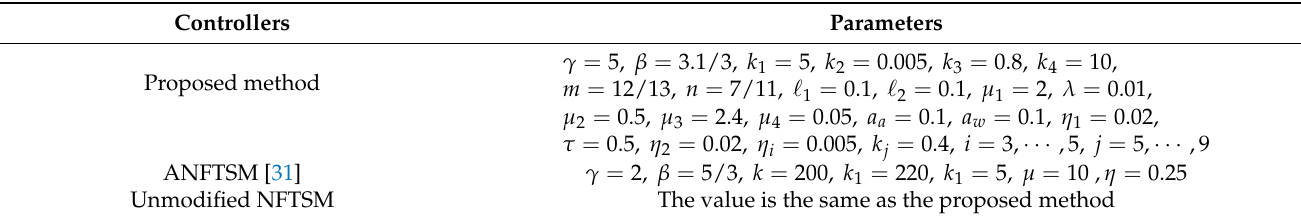
Table 3. Controller parameters